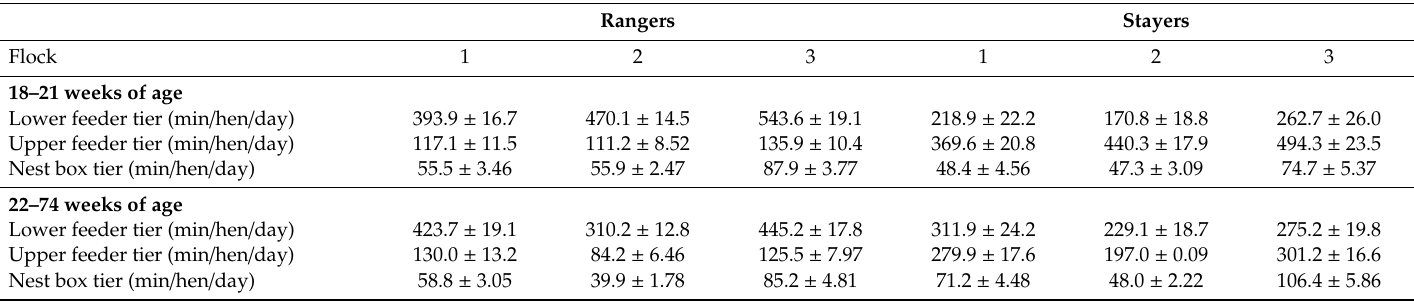
Table 2. Time average spent at various location inside the shed (mean ± SEM) of hens ( n = 769) obtained from 3 flocks that were categorized and housed according to their range use during early (18–21 weeks of age) and whole (22–74 weeks of age) ranging